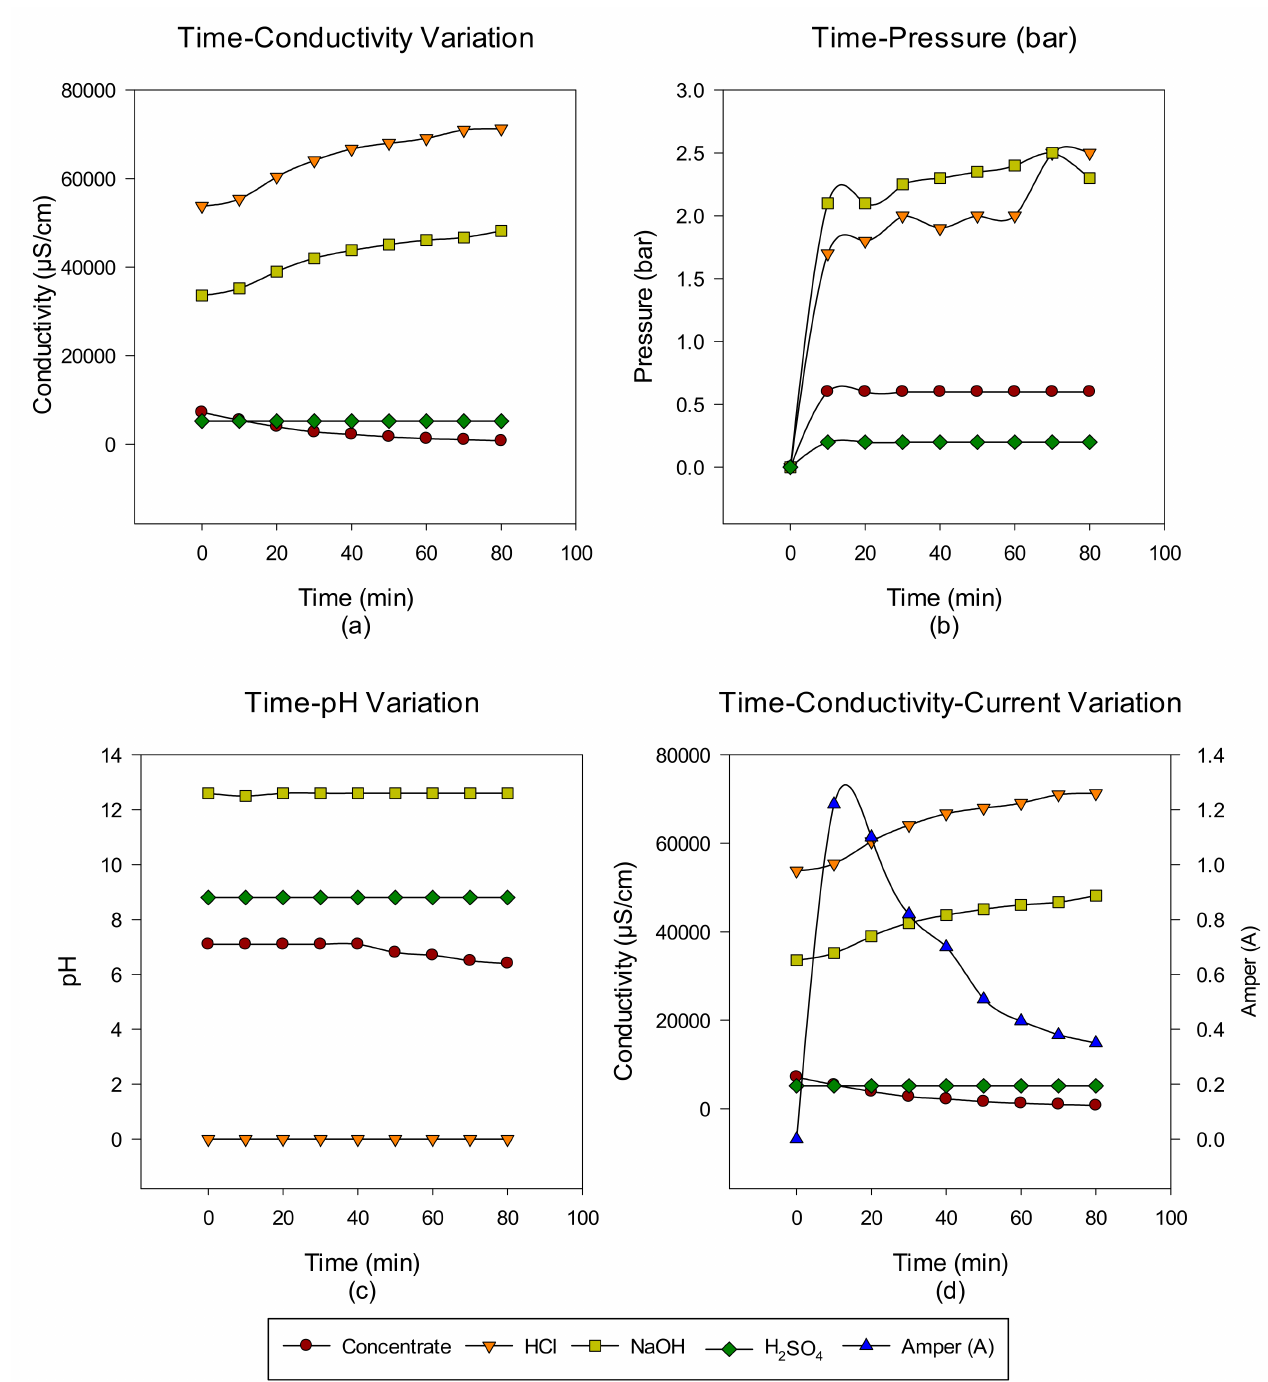
Figure 6. Between 0 and 80 min, NaCl–NaOH–HCl–Na 2 SO 4 ( a ) conductivity, ( b ) pressure, ( c ) pH, and ( d ) conductivity and ampere